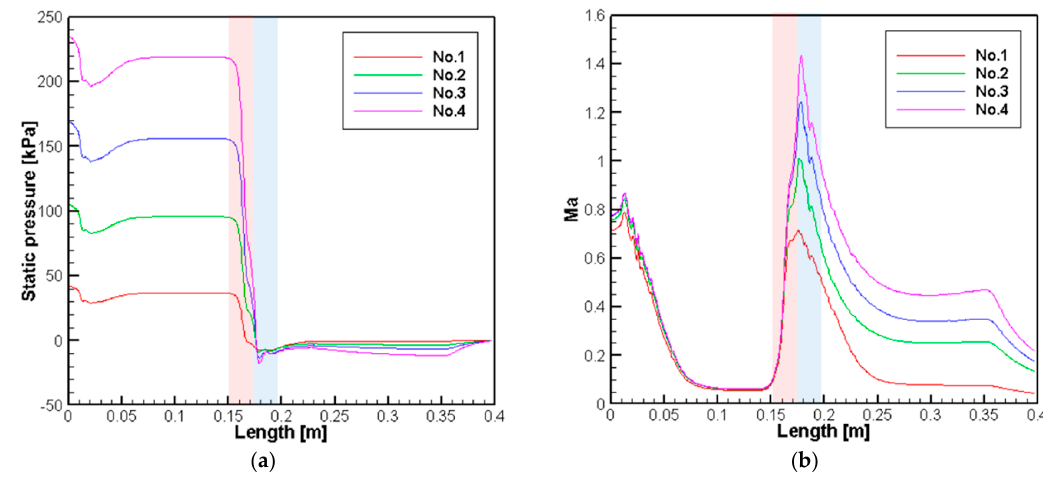
Figure 13. Static gauge pressure and Mach number along the center line of air nozzle: ( a ) static pressure distribution; ( b ) Mach number distribution (red: nozzle; blue: mixing section). Table 3. Static pressure and velocity at an air inlet.